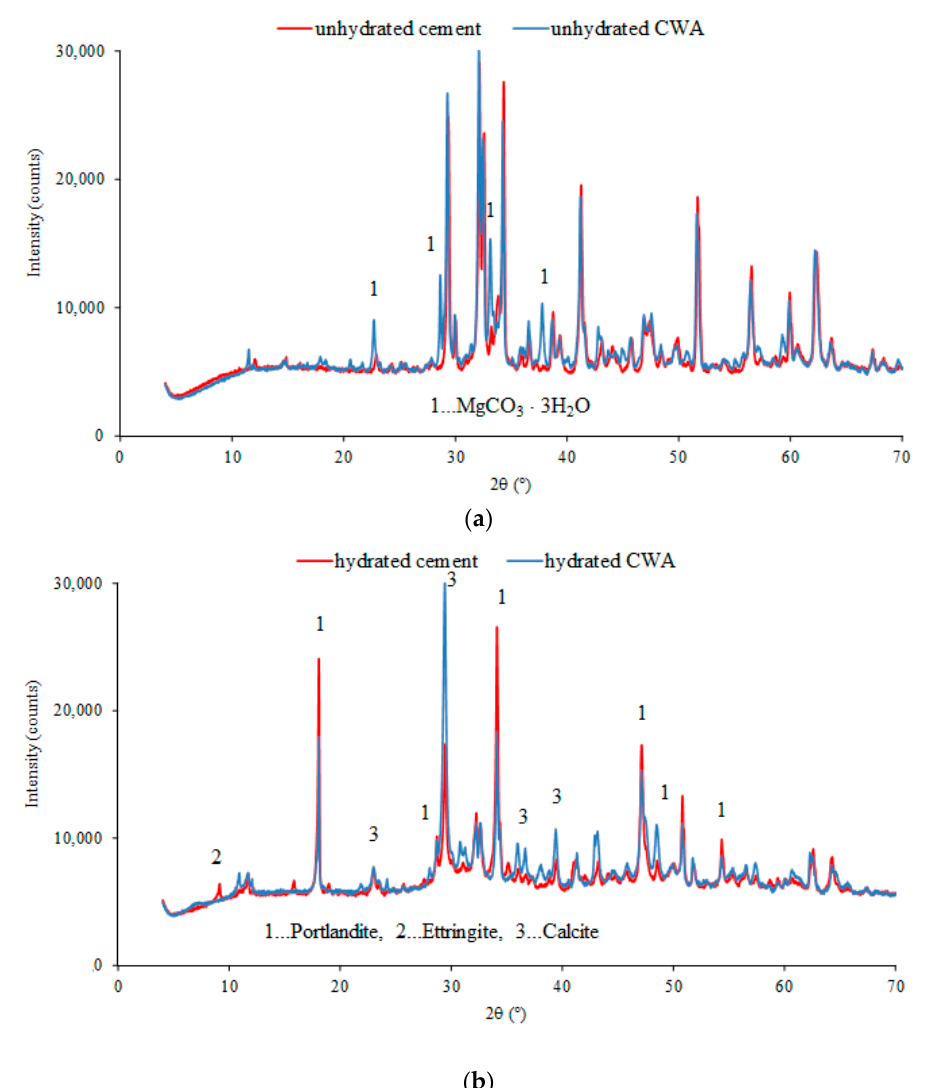
Figure 8. XRD diffractogram of cement and CWA: ( a ) before hydration and ( b ) after 57 days of hydration .